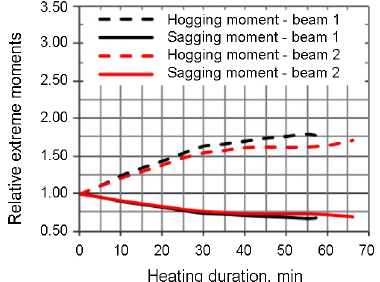
Fig. 8. Relative changes of extreme bending moments: hogging and sagging